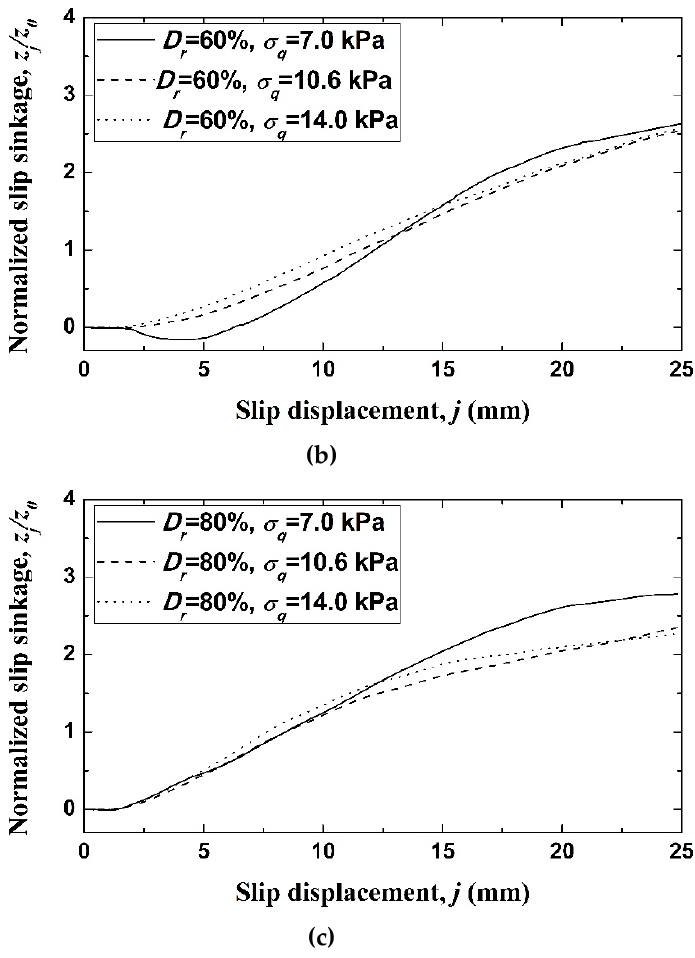
Figure 10. Normalized slip sinkage and slip displacement relationships for ( a ) D r = 40%, ( b ) D r = 60%, and ( c ) D r = 80%.